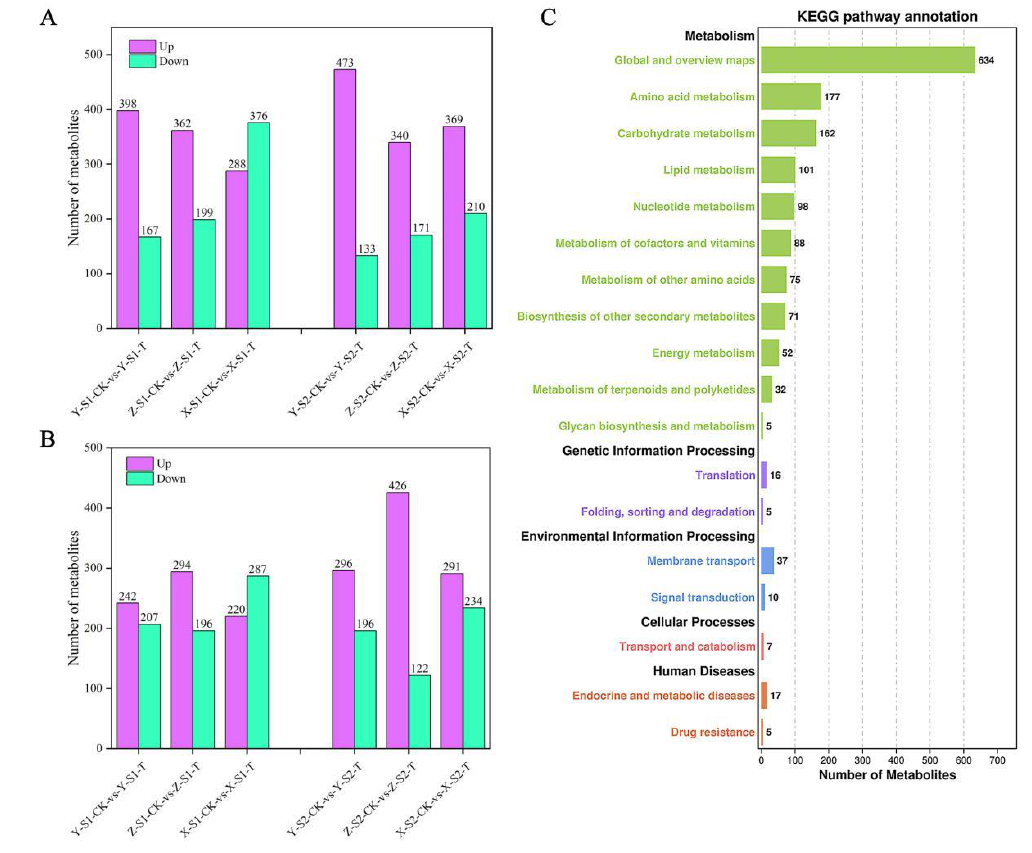
Figure 9. Quantitative statistics of DAMs and their enrichment in different metabolic pathways. ( A , B ) The number of DAMs in positive and negative channel, respectively. The six columns on the left are the statistical results of S1 DAMs in the S1 growth period, and the six columns on the right are the statistical results of S2 growth period. The purple column is the number of metabolites with up-regulated abundance, and the green column is the statistics of the number of metabolites with down-regulated abundance; ( C ) The number of DAMs in different metabolic pathways by KEEG enrichment analysis. The number marked on the column was the number of DAMs enriched in this metabolic pathway.